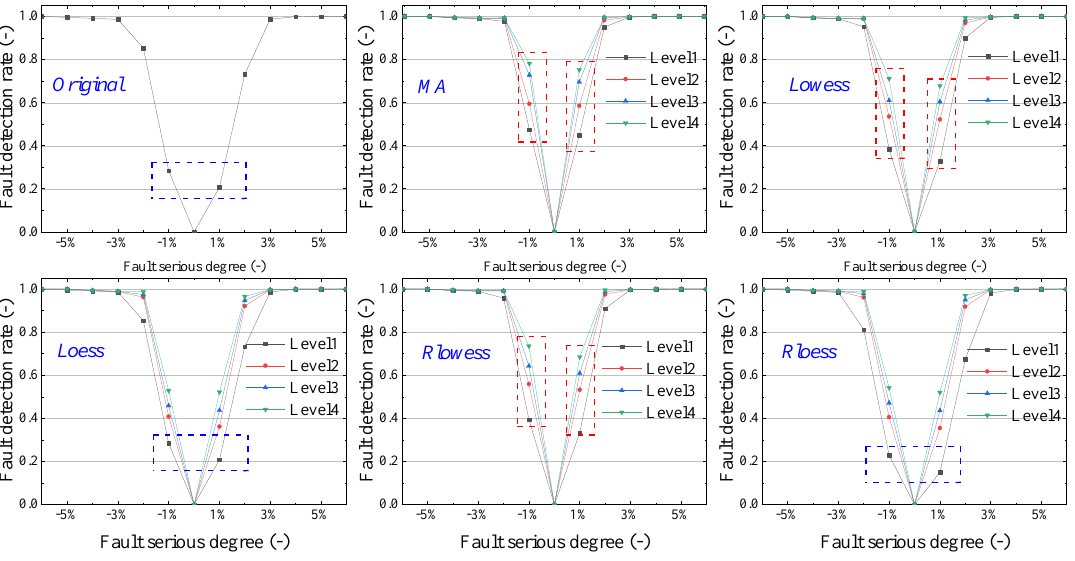
Figure 7. Fault detection results of different optimized PCA models for the cooling water flow sen- sor.